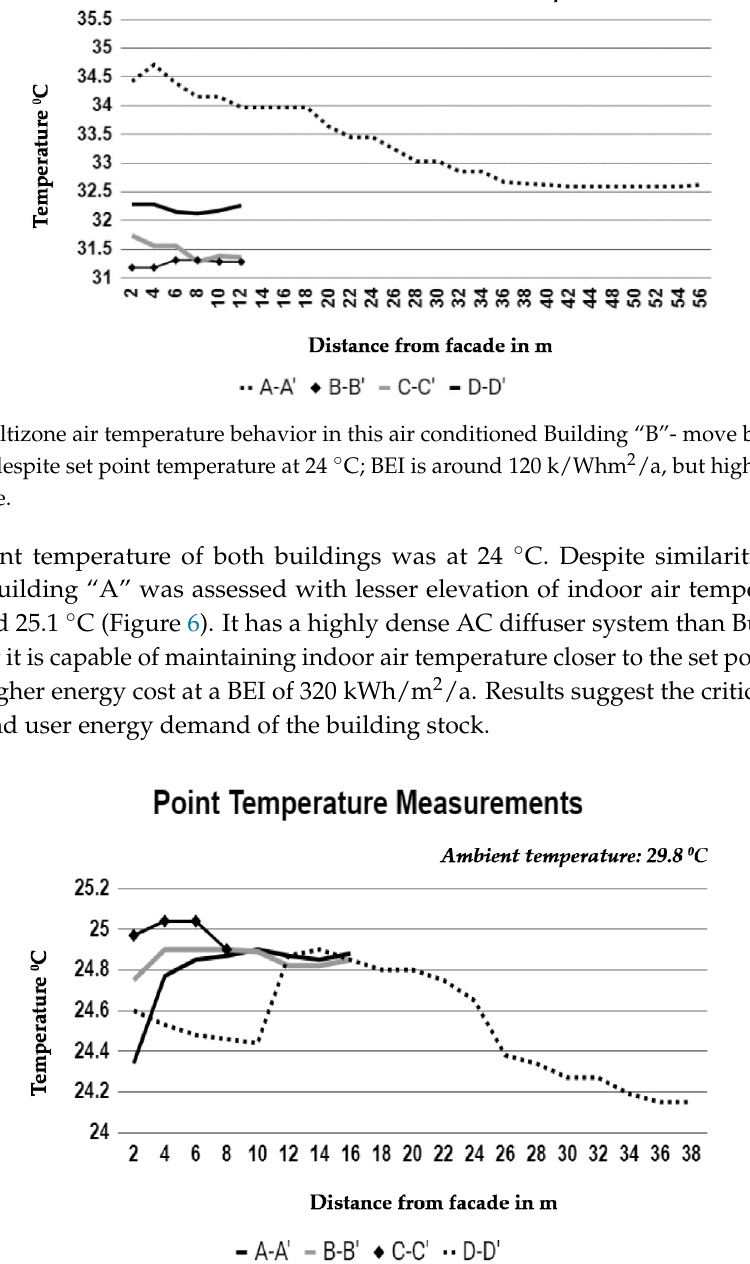
Figure 6. Multizone air temperature behavior of this air conditioned Building “A” moves just 1.1